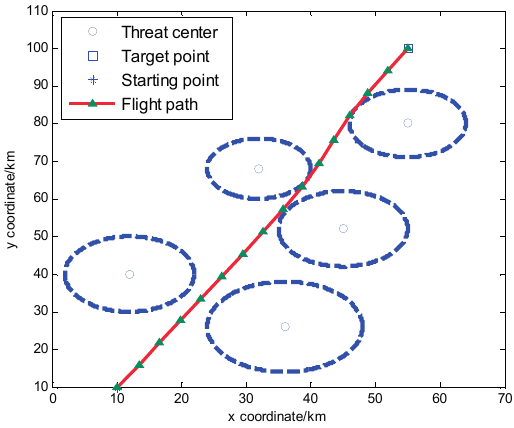
Figure 5. Result of the first instance for D =